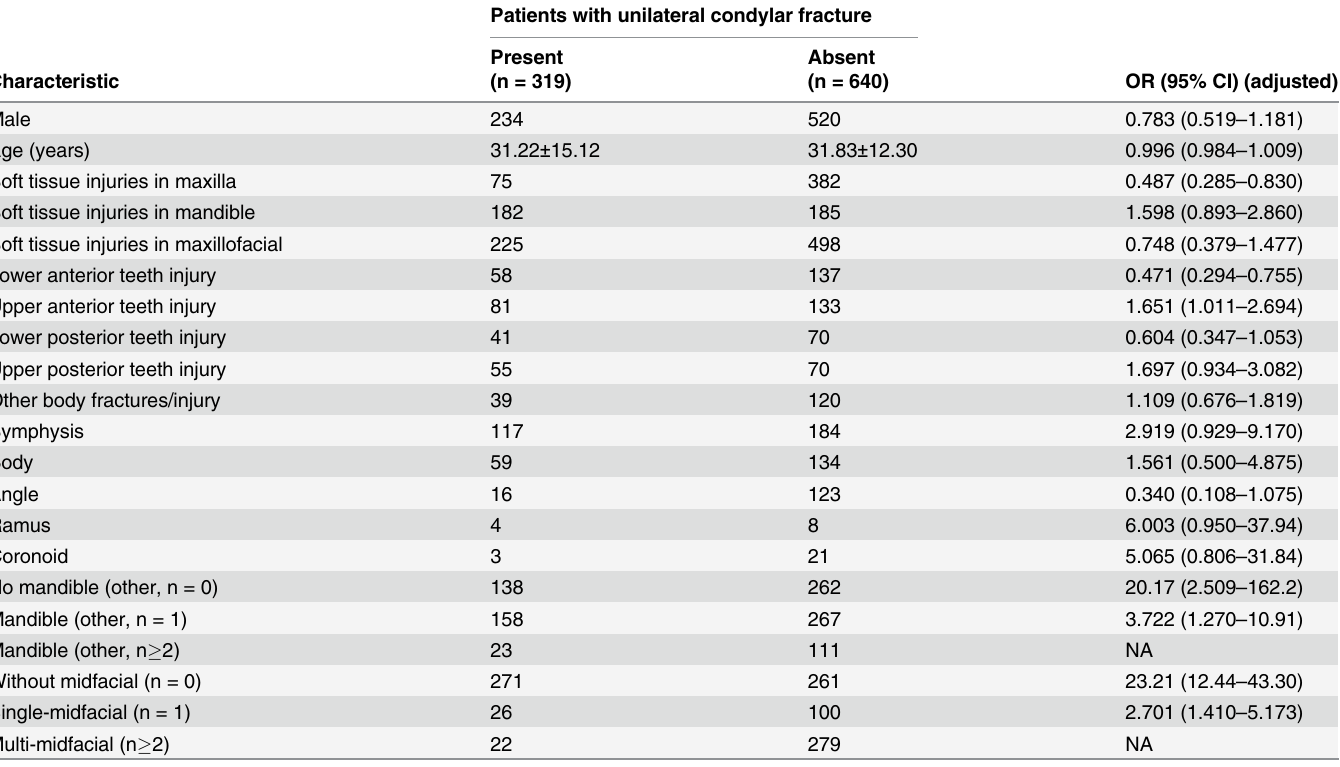
Table 3. Multivariate logistic regression analysis of patients with unilateral condylar fractures. Patients with unilateral condylar